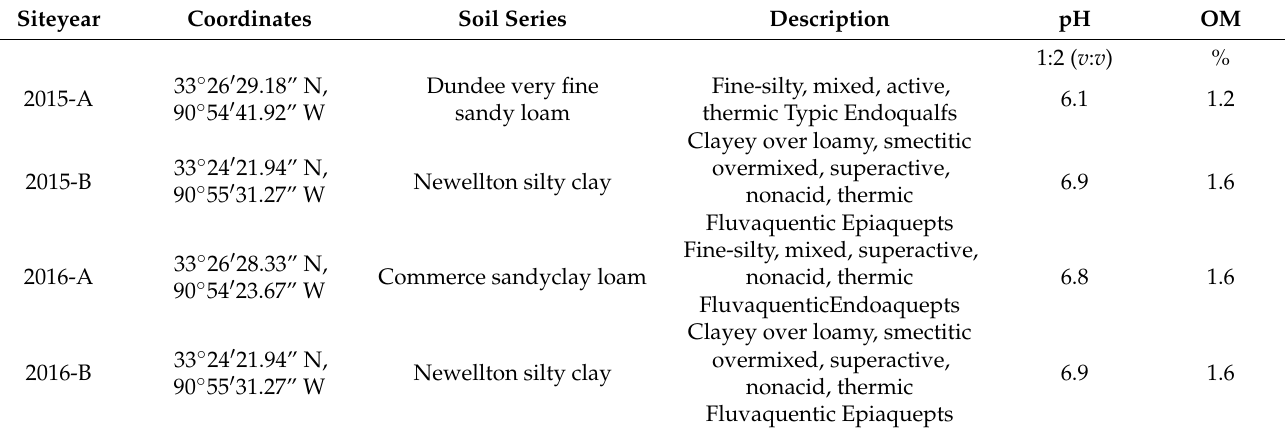
Table 1. Global positioning system (GPS) coordinates, soil series, soil description, soil pH, and soil organic matter (OM) for weed control studies conducted in Stoneville, MS during 2015 and 2016 to determine the response of tank mixtures containing cytokinins and POST herbicide treatments in